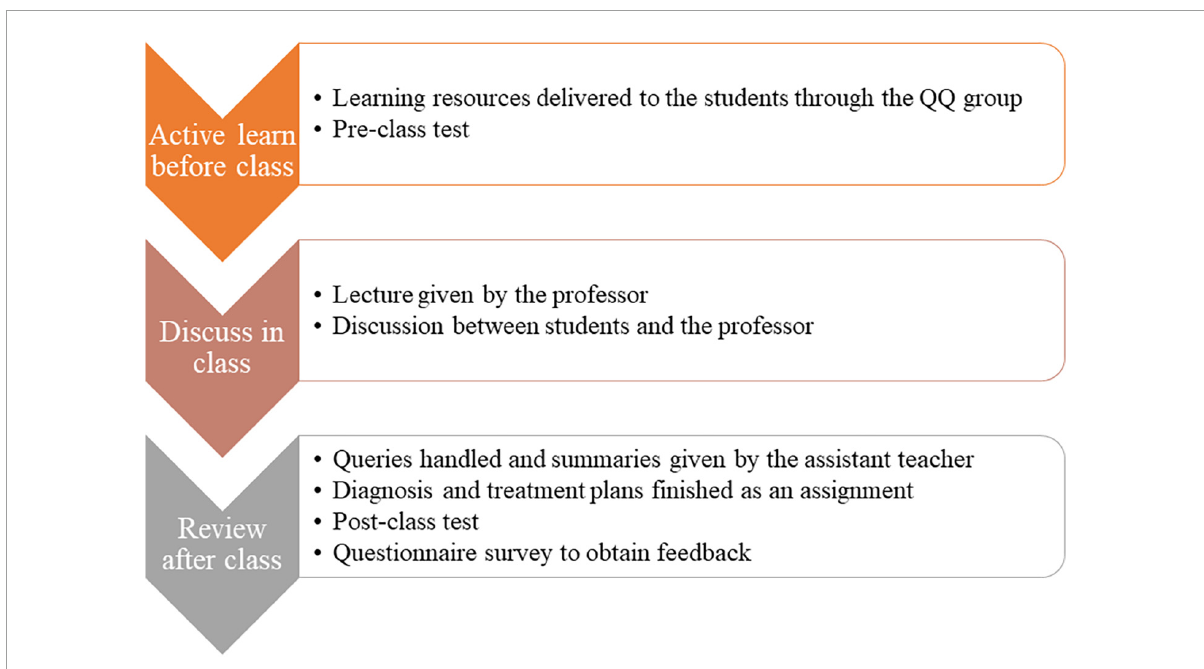
FIGURE2 The diagram of the teaching process under the diverse online neurology teaching mode.